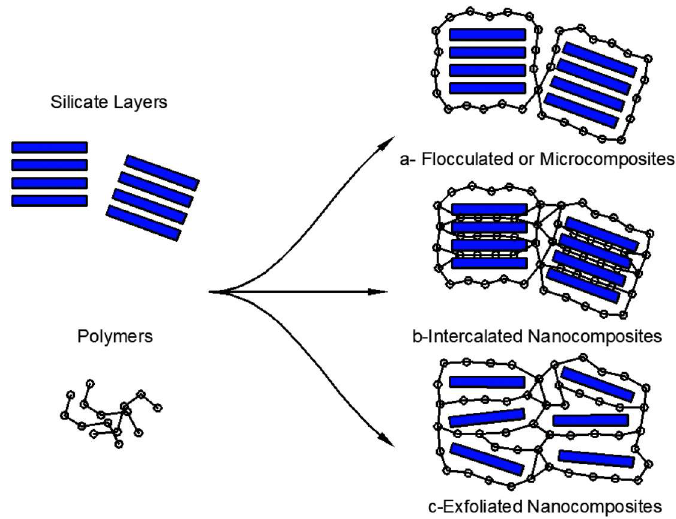
Figure 3. Morphology of polymer nanoclays: ( a ) microcomposite or flocculated, ( b ) intercalated nanocomposite, and ( c ) exfoliated nanocomposite.